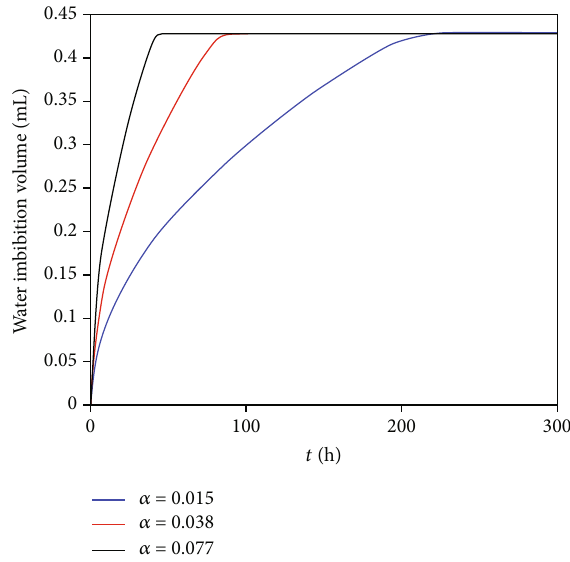
Figure 5: Water imbibition curves under various a